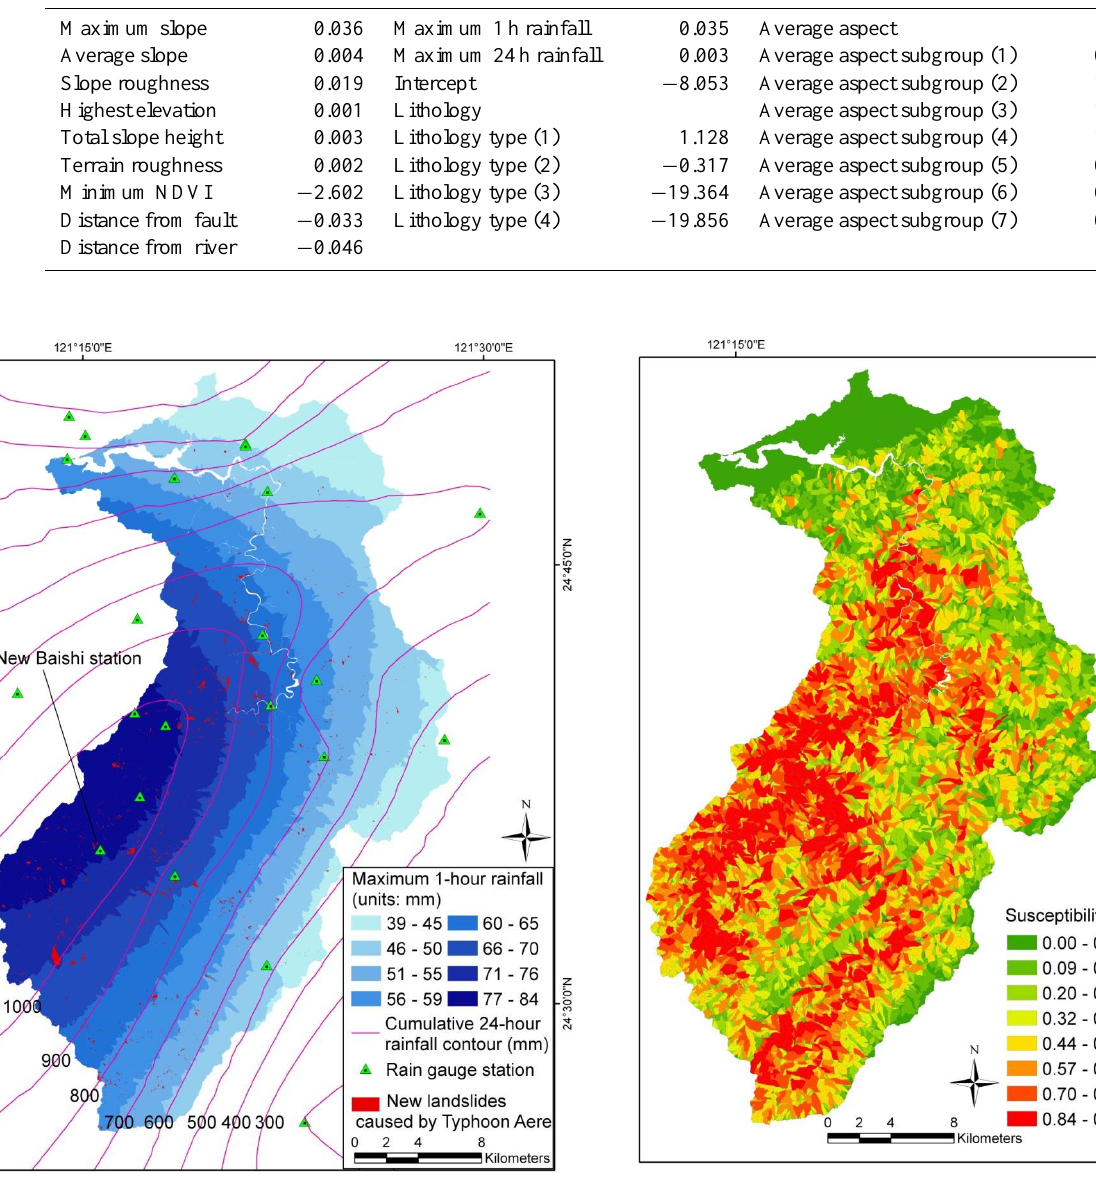
Fig. 4. Maximum 1h and cumulative 24h rainfall during Typhoon Aere. Fig. 5. Landslide susceptibility map based on logistic regression model using rainfall of 3 Fig. 4. Maximum 1 h and cumulative 24 h rainfall during Typhoon Aere. 3